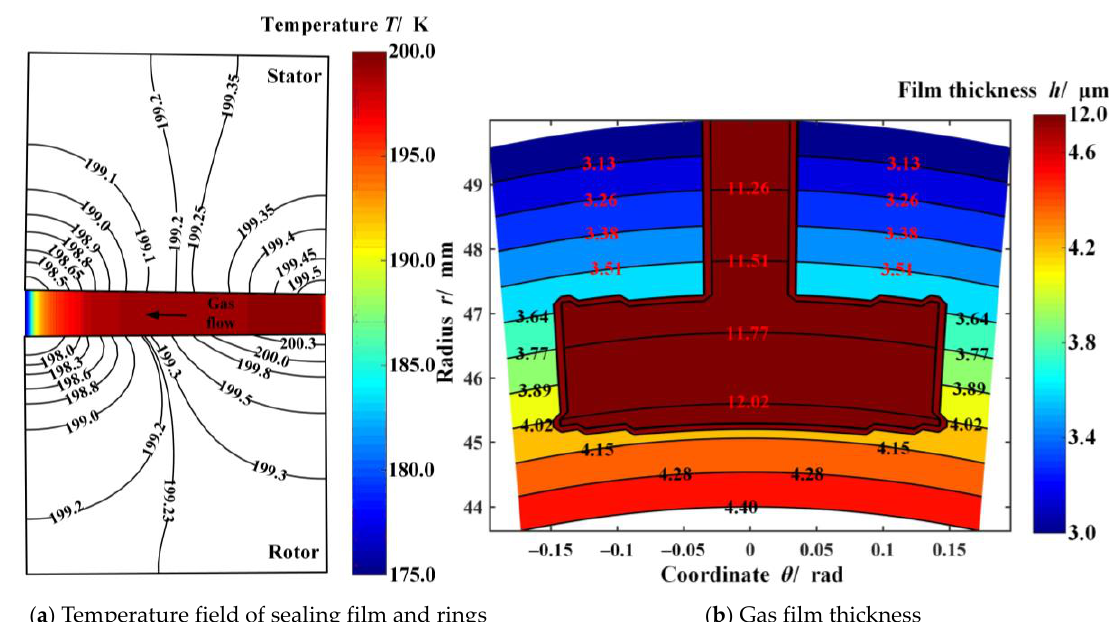
Figure 3. Cross–sectional temperature field and gas film thickness considering face distortions ( h 0 = 3.0 μm, ω = 20,000 r·min −1 , p o = 5.0 MPa, T o = 200 K).